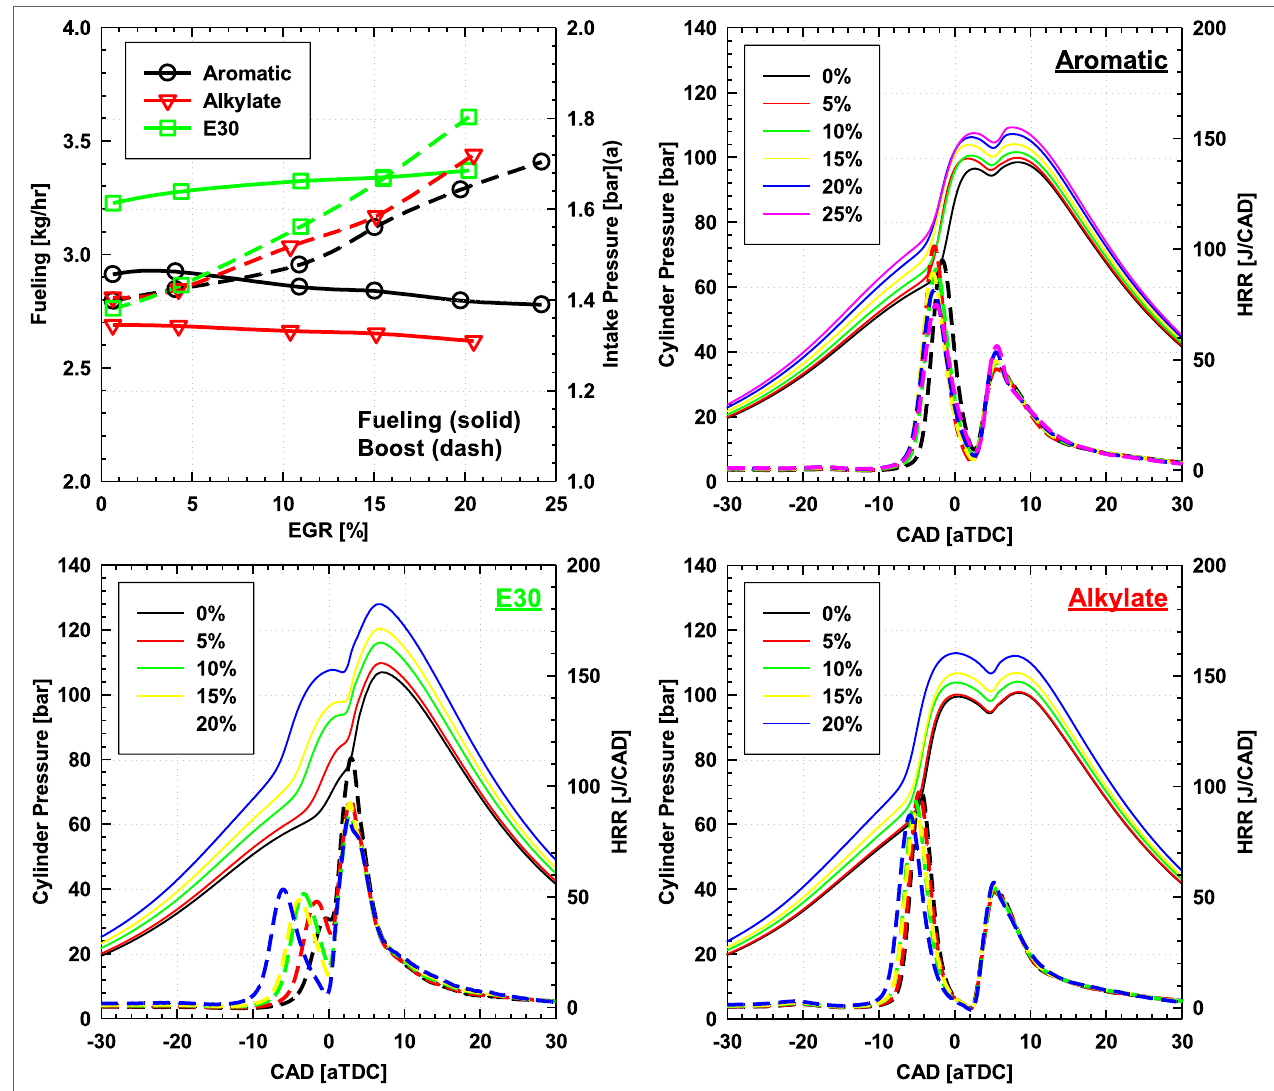
FigUre 5 | Exhaust gas recirculating (EGR) sweep (0–25%) results with intake pressure adjustment for constant combustion phasing: fuel mass flow rate and combustion delay (top left) and cylinder pressure and heat release of each fuels (aromatic, alkylate, and